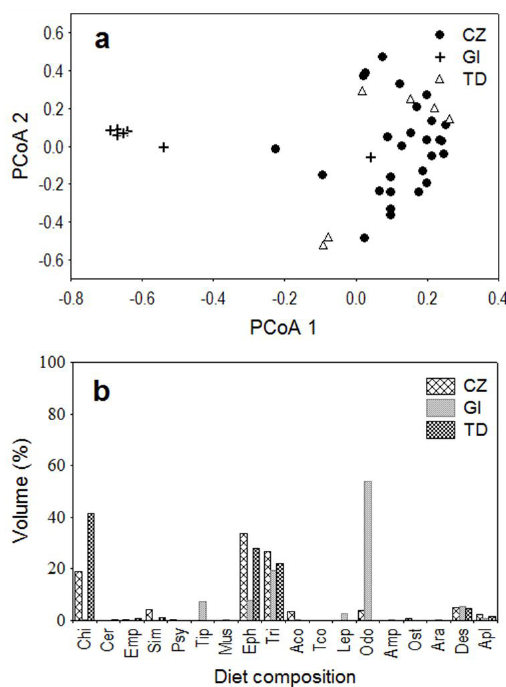
Figure 3. Diet data ordination (using the first two axes of PCoA that explained 34% of the data variance) (a) and diet composition (b) of fish species sampled in the Zaúna stream. CZ= C. zebra ; CI= C. iheringi ; IB= I. borodini ; Chi= Chironomidae; Emp= Empididae; Sim= Simuliidae; Mus= Muscidae; Eph= Ephemeroptera; Tri= Trichoptera; Aco= Aquatic Coleoptera; Tco= terrestrial Coleoptera; Lep = aquatic Lepidoptera; Tle= terrestrial Lepidoptera; Ple= Plecoptera; Odo= Odonata; Oli= Oligochaeta; Amp = Amphipoda; Ost = Ostracoda; Hom= Homoptera; Hym= Hymenoptera; Des= detritus/sediment; Apl= aquatic